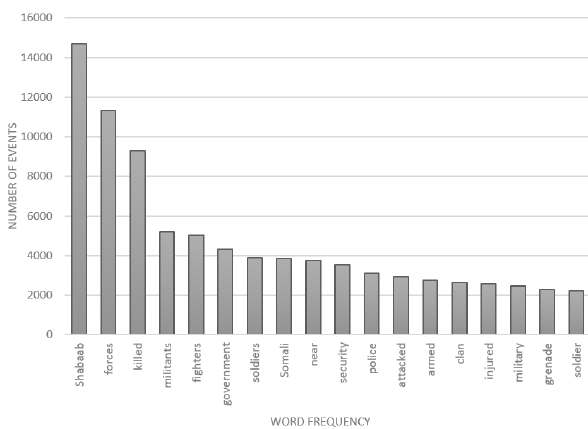
Figure 3. Relevance and frequency of identifies conflict